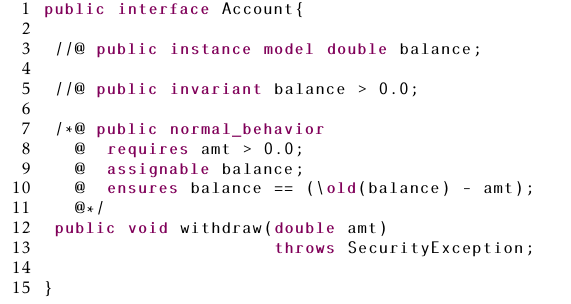
Figure 1. AnExcerptof a JML-annotatedBankingApplication. execution, assuming its corresponding